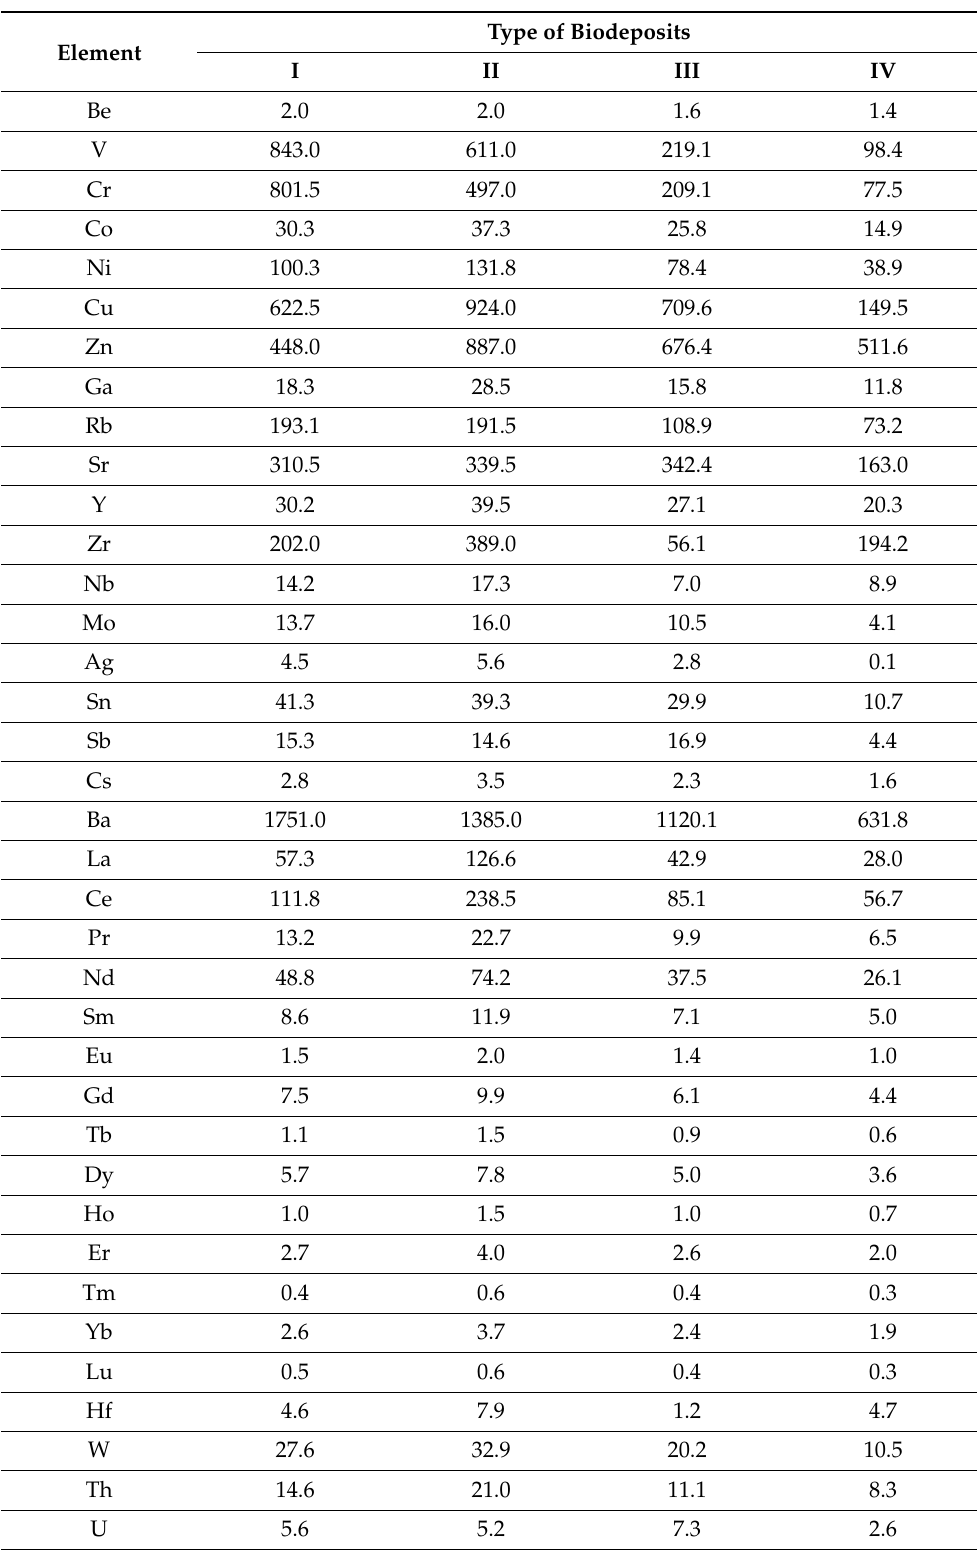
Table 4. The average content of the trace impurity elements (mg/kg) 1 in the biodeposits (ICP MS analysis